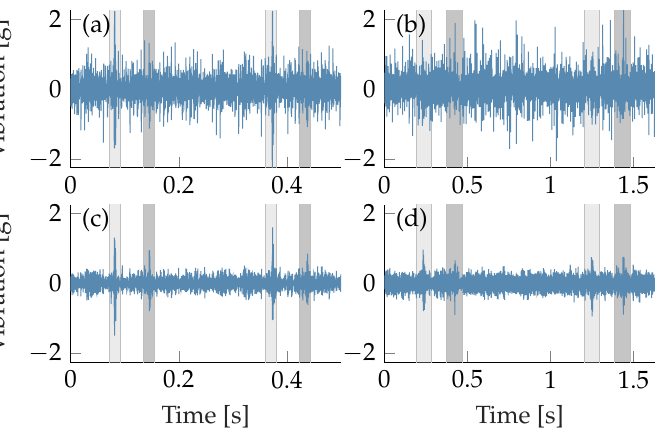
Figure 16. Results of multiband FIR filtering for the gearbox with damage on gear z 1 ( a ) unfiltered— ( c ) filtered and for the gearbox with damage on gear z 3 ( b ) unfiltered—( d ) filtered. The rotational speed is 200rpm and the torque is